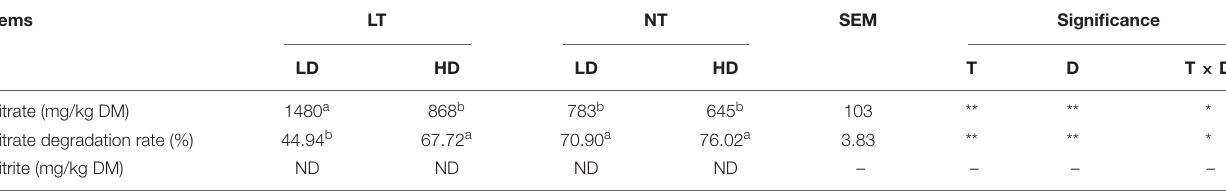
TABLE 4 | Nitrate concentration, nitrate degradation rate, and nitrite concentration of sorghum-sudangrass silage ( n = 3). Items LT NT